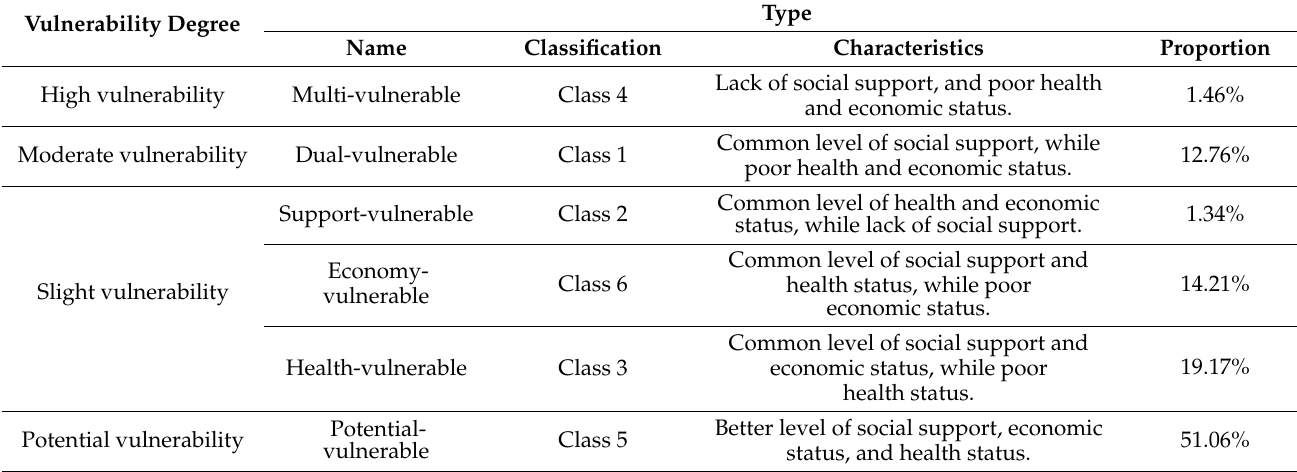
Table 7. Types of vulnerable older